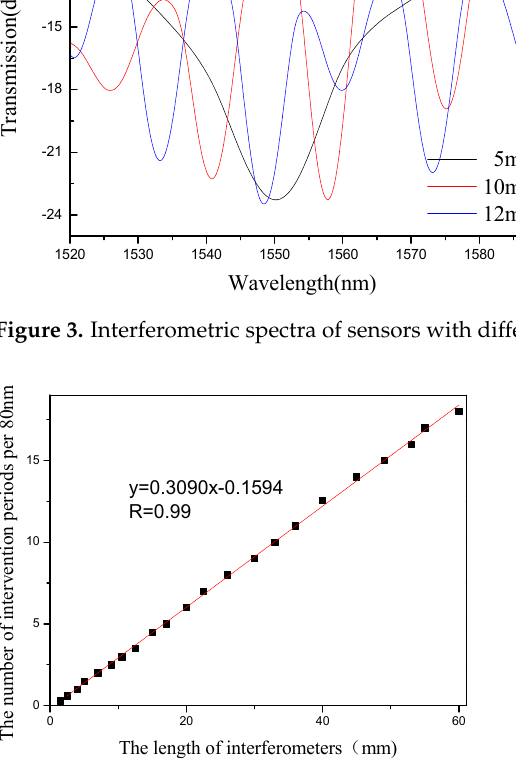
Figure 4. Relationship between interference period and interference arm length in the 80 nm spectral range.